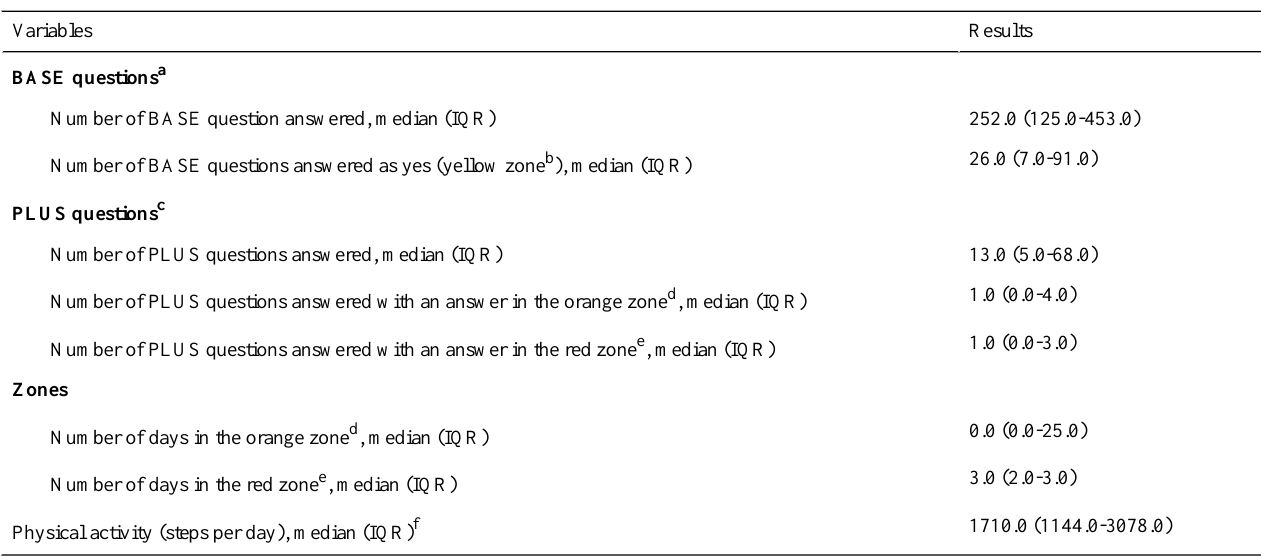
Table 4. EmmaCOPD outcomes (n=29), with results categorized in zones (green, yellow, orange, or red), with each zone except green (steady state) requiring a different